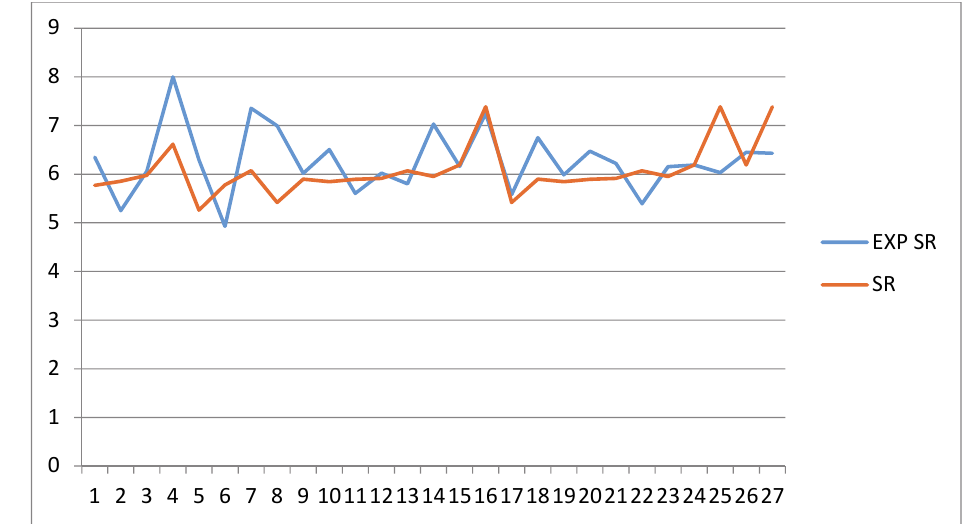
Fig. 12. Experimental SR VS ANN SR